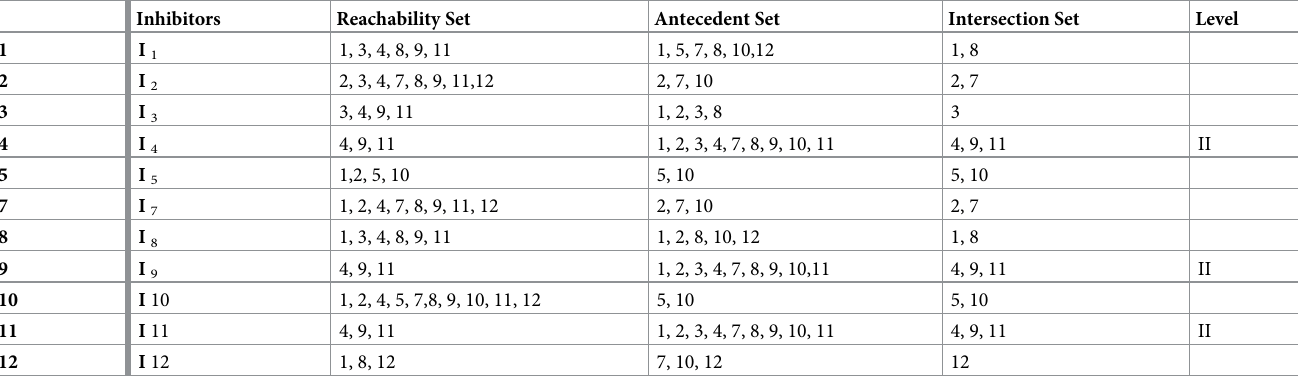
Table 8. Level partitioning iteration